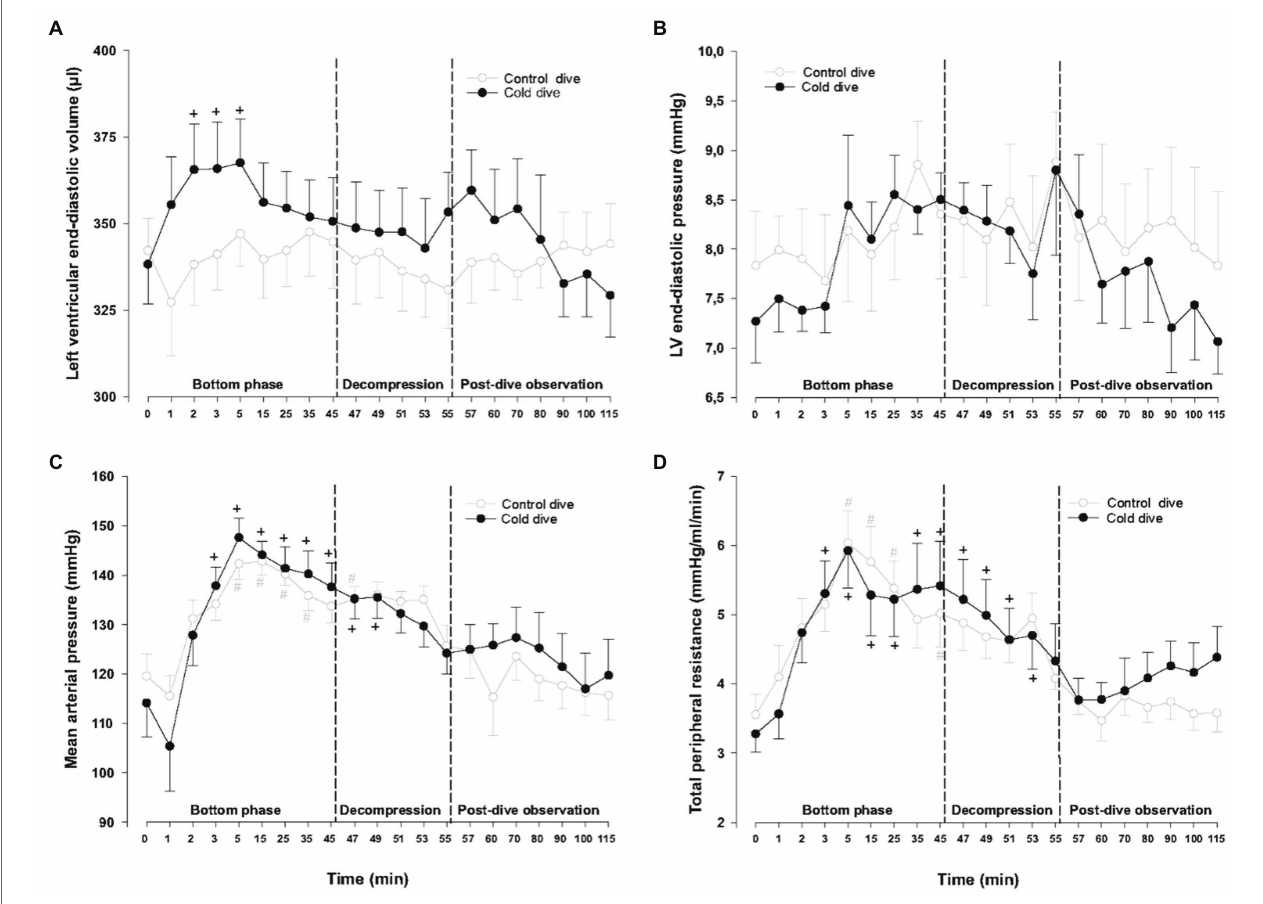
FIGURE 3 | Hemodynamic variables (cont.). (A) Left ventricular end-diastolic volume (LVEDV), (B) left ventricular end-diastolic pressure (LVEDP), (C) mean arterial pressure (MAP), and (D) total peripheral resistance (TPR). Data are mean ± SEM. N = 9 in both groups. + p < 0.05 compared to baseline in the cold dive group. # p < 0.05 compared to baseline in the control dive group. Data for the control dive group are adapted from Gaustad et al.